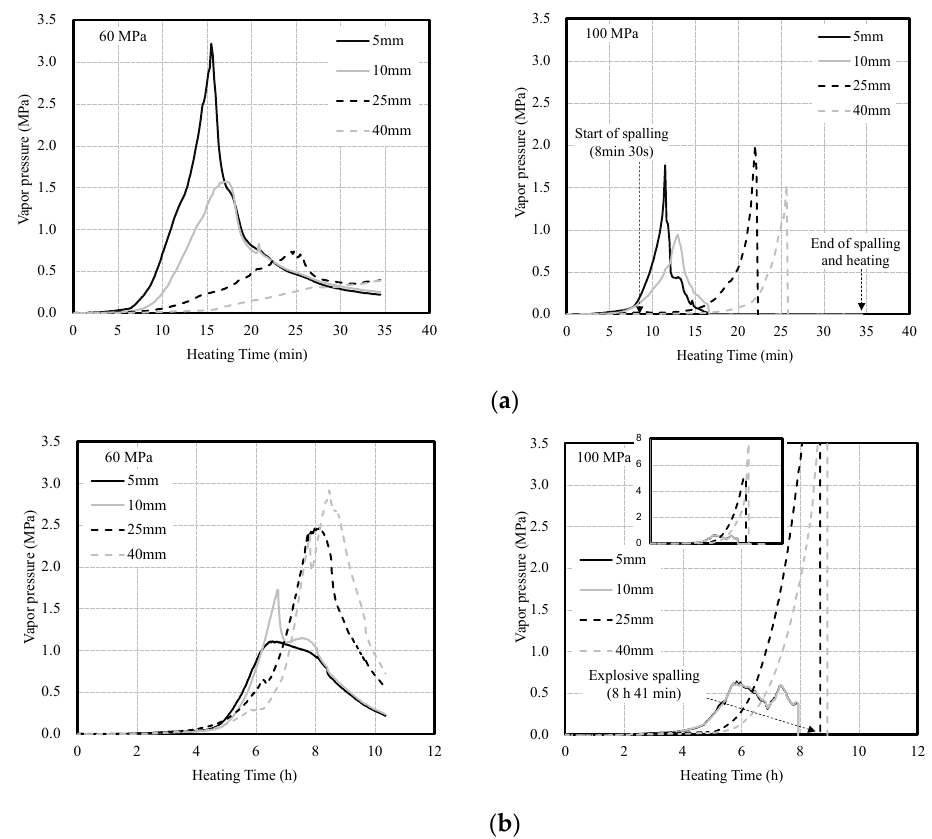
Figure 7. Vapor pressure of concrete according to heating rate. ( a ) Fast heating (ISO-824). ( b ) Slow heating (1 °C/min).